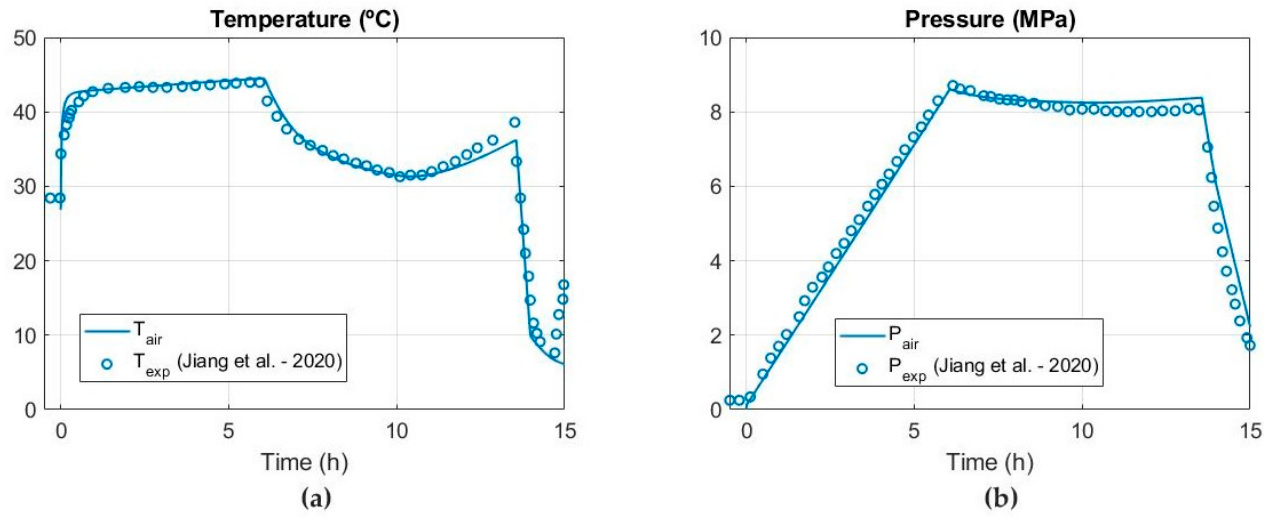
Figure 16. Comparison of results obtained during the first cycle with an experimental model developed by Jiang et al. [24]. ( a ) Air temperature; ( b ) Air pressure.